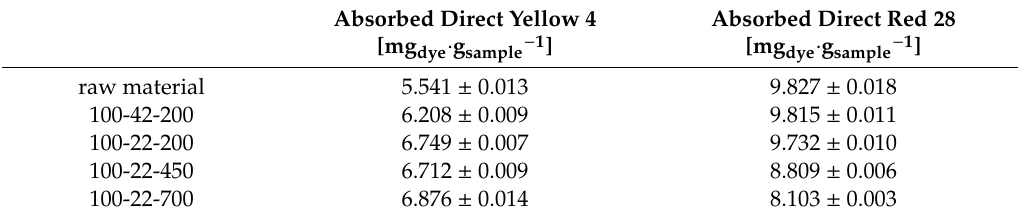
Figure 10. Scanning electron microscope photographs of apple pomace surfaces. ( A , B ) show the raw material. ( C , D ) show the surface of apple pomace extruded at T barrel = 100 ◦ C and a water content of 17%, using a screw speed of 200 min − 1 (100-17-200). Table 6. Absorption of DY 4 and DR 28 of raw material and various extruded apple pomace samples for a barrel temperature of 100 ◦